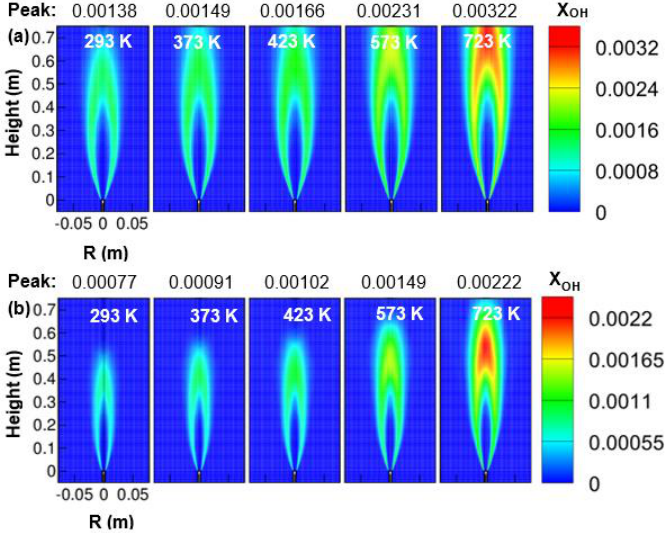
Figure 9 . Contours of OH mole fraction as a function of air temperature; ( a ) 1 atm, and ( b ) 3 atm.